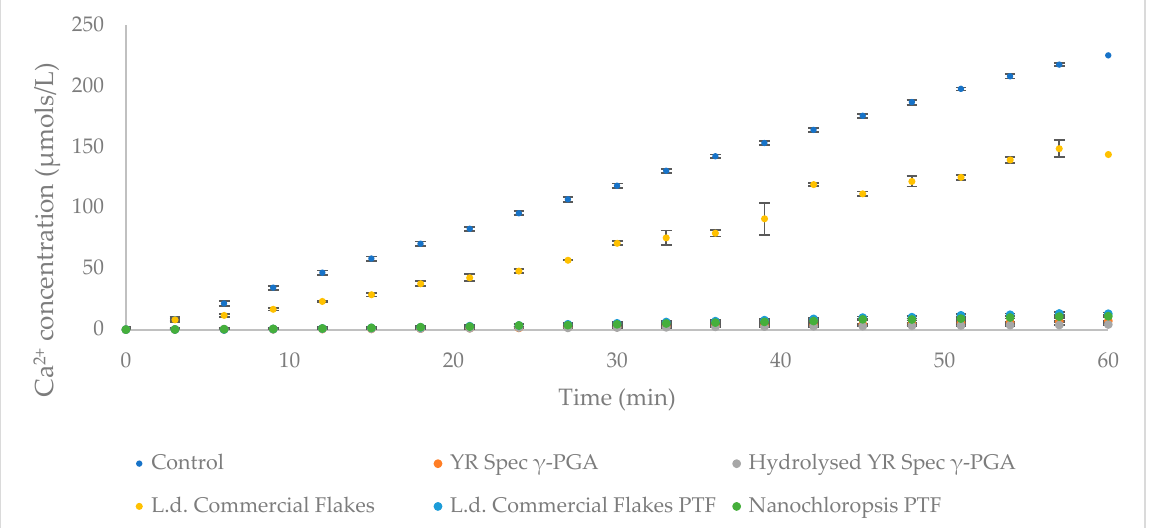
Figure 8. Protective effect of 1% (w/v) γ -PGA formulations obtained from micro- and macro-algal substrate towards HAp discs. The γ -PGA formulations tested were comprised of water only (con- trol), commercial -440 KDa- γ -PGA (YR Spec γ -PGA), Commercial γ -PGA hydrolytically degraded (Hydrolysed YR Spec γ -PGA), γ -PGA produced from algal biomass raw precipitate, before tangential flow (L.d. Commercial Flakes), γ -PGA produced from algal biomass after tangential flow (L.d. Commercial Flakes PTF), γ -PGA produced from pre-solvent extracted, waste, micro-algal biomass fraction after tangential flow (N.o Commercial Powder PTF). A detailed summary of the cultivation media components (where applicable) can be found within Table 1. All HAp discs were immersed in the formulation for 5 min. n = 3. Error bars indicate standard error values. The data again showed that all of the 1% (w/v) formulations tested demonstrated HAp protection, compared to control. The formulation which displayed the least protec- tion was L.d. Commercial Flakes. All the other formulations displayed similar demineral- isation inhibition.